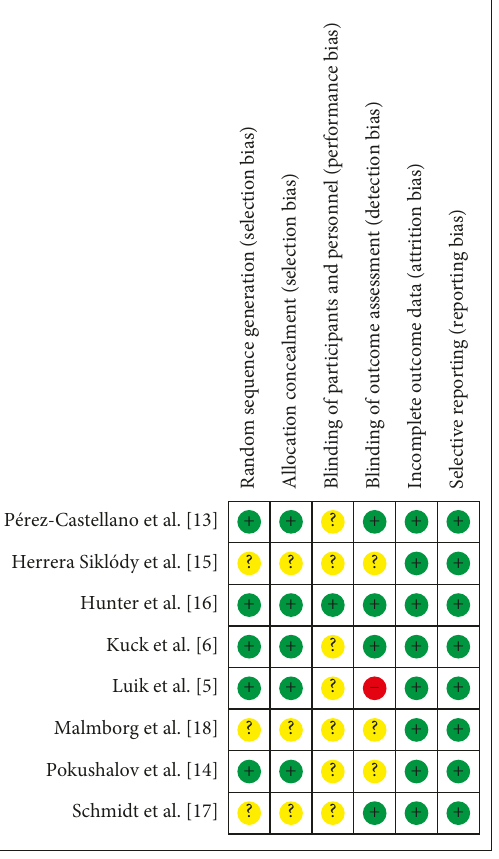
Figure 2: Risk of bias of included studies in the